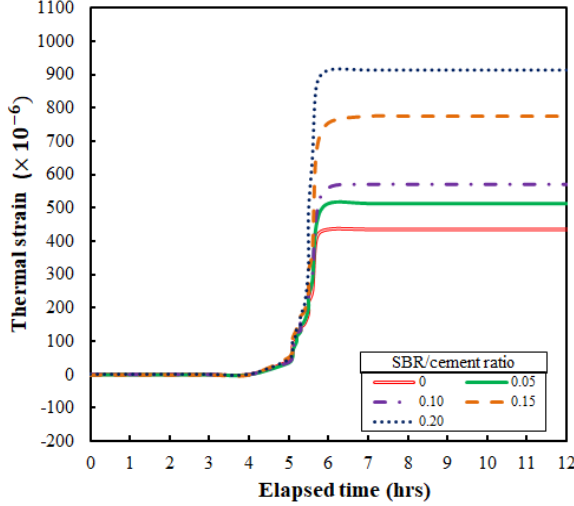
Figure 10. Thermal strains for different SBR/cement ratios.